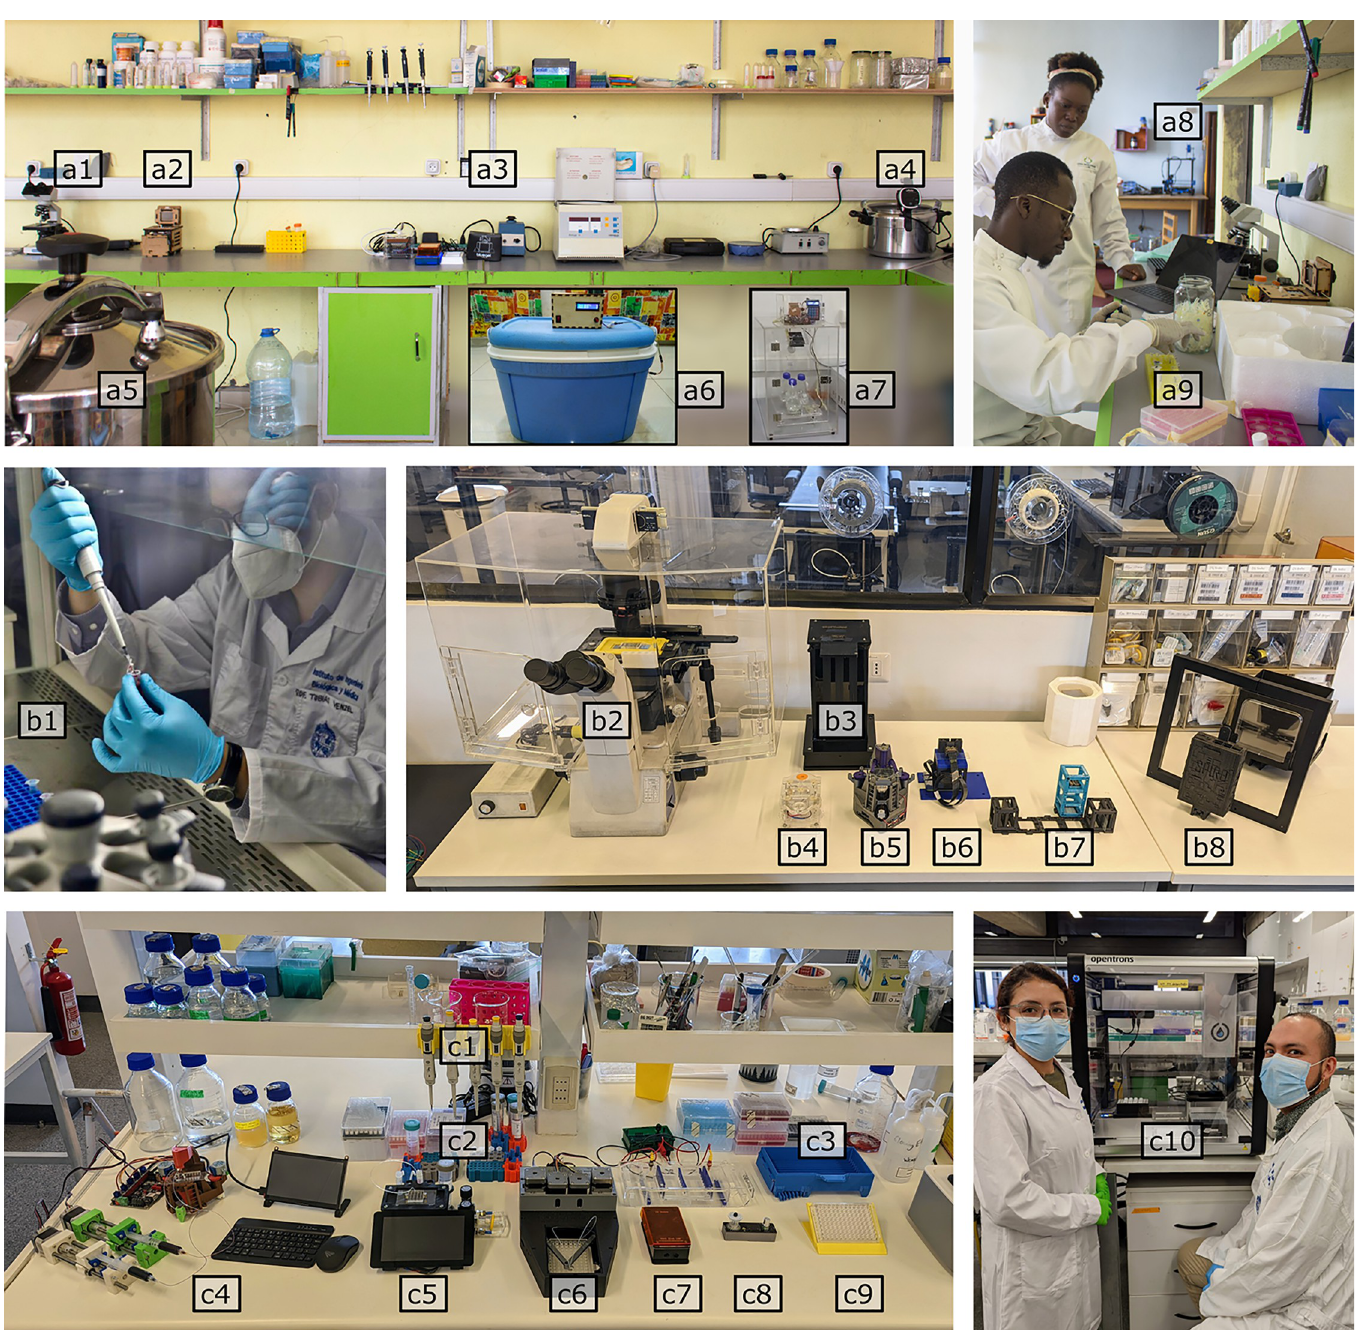
Fig 3. Examplesofbiology laboratoriesequippedwithopentechnology. The top imagesshow the MboaLab inCameroon(source:openbioeconomy.org)andmiddleand lower imagesshow the WenzelLab inChile.The following equipmentis shown:basic commerciallight microscope(a1),openhardwarethermocycler (rebuildofOpenPCR)(a2), small commercialDNAanalysisequipment(miniPCR,bluegel,vortexter,centrifuge)(a3), repurposedSous Videaswater bath(a4), repurposedpressurecookerasautoclave(a5), self- designedopenhardwareincubator(a6),self-designedopenhardwareshakingincubator(a7), commercialopenhardware3Dprinter(a8), use ofreagentsandopenenzymes(a9). Secondhandcommerciallaminarflowhood(b1),secondhand commercial microscopewith customenclosureand3D-printedsampleandcameraadaptors(b2),opensource laser- cut fluorescence plateimaging station(rebuilt;[48])(b3),openlaser-cut smartphone microscope(RoachscopefromBackyardBrains)(b4),open3D-printedOpenFlexure microscopeinfluorescence configuration (rebuiltand star-LEDfitted;[49])(b5),3D-printedcomputational microscope (rebuiltwithUnicornRaspberryPi hat)(b6), open3D- printedholographic microscope(UC2rebuild;[31])(b7),opentime-lapse multiplePetriplate imagingsystem(SPIROrebuildin progress;[50])(b8).Student-designed3D-printed pipetteholderswithearthquakesafety (c1),open3D-printed tuberacks(rebuiltfromDormantBiologyLab design)(c2),3D-printedpipettetip alignerfor tipbox refill(Elster rebuild)(c3),self-designedmicrofluidicseducational workstation(Raspberry Pi–basedcontrolof3D-printedsyringepumpsand microscope) (c4),openworkstation for